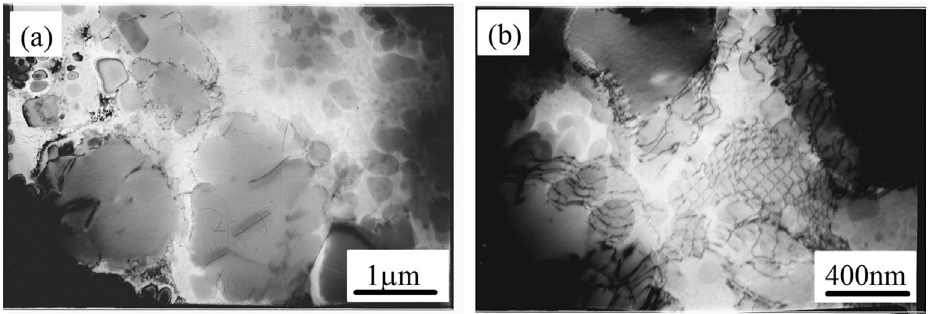
Fig. 4: Deformation structure of aged alloy at 1100 °C: (a) dislocations and dislocation pairs, (b) square dislocation